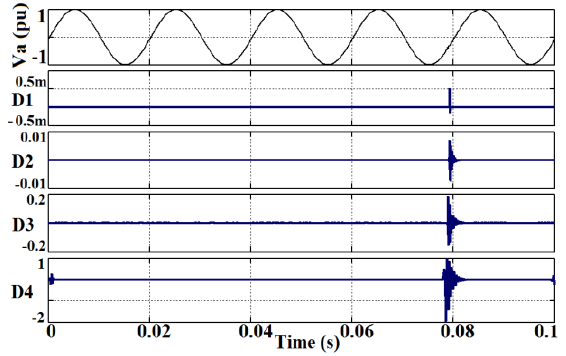
Figure 9. DWT details for switching